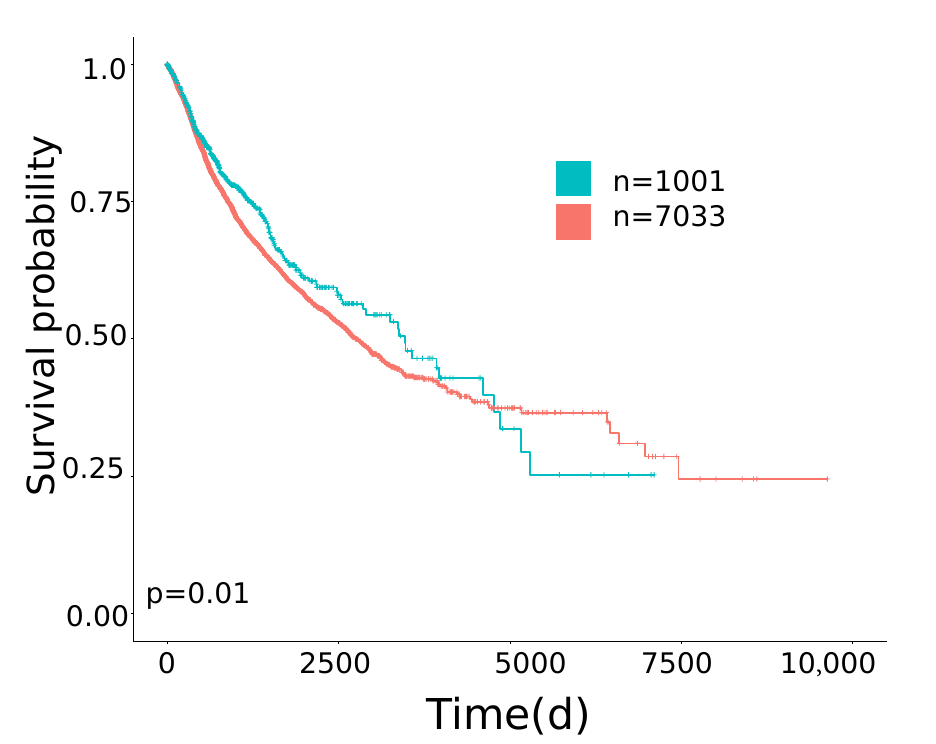
Figure 1. Kaplan-Meier Overall Survival (OS) curves of TMB/TGF- β score positive cases (blue line) versus TMB/TGF- β score negative cases (red line) for the 29 TCGA cancer types. Time is expressed in days; log-rank test p-value is